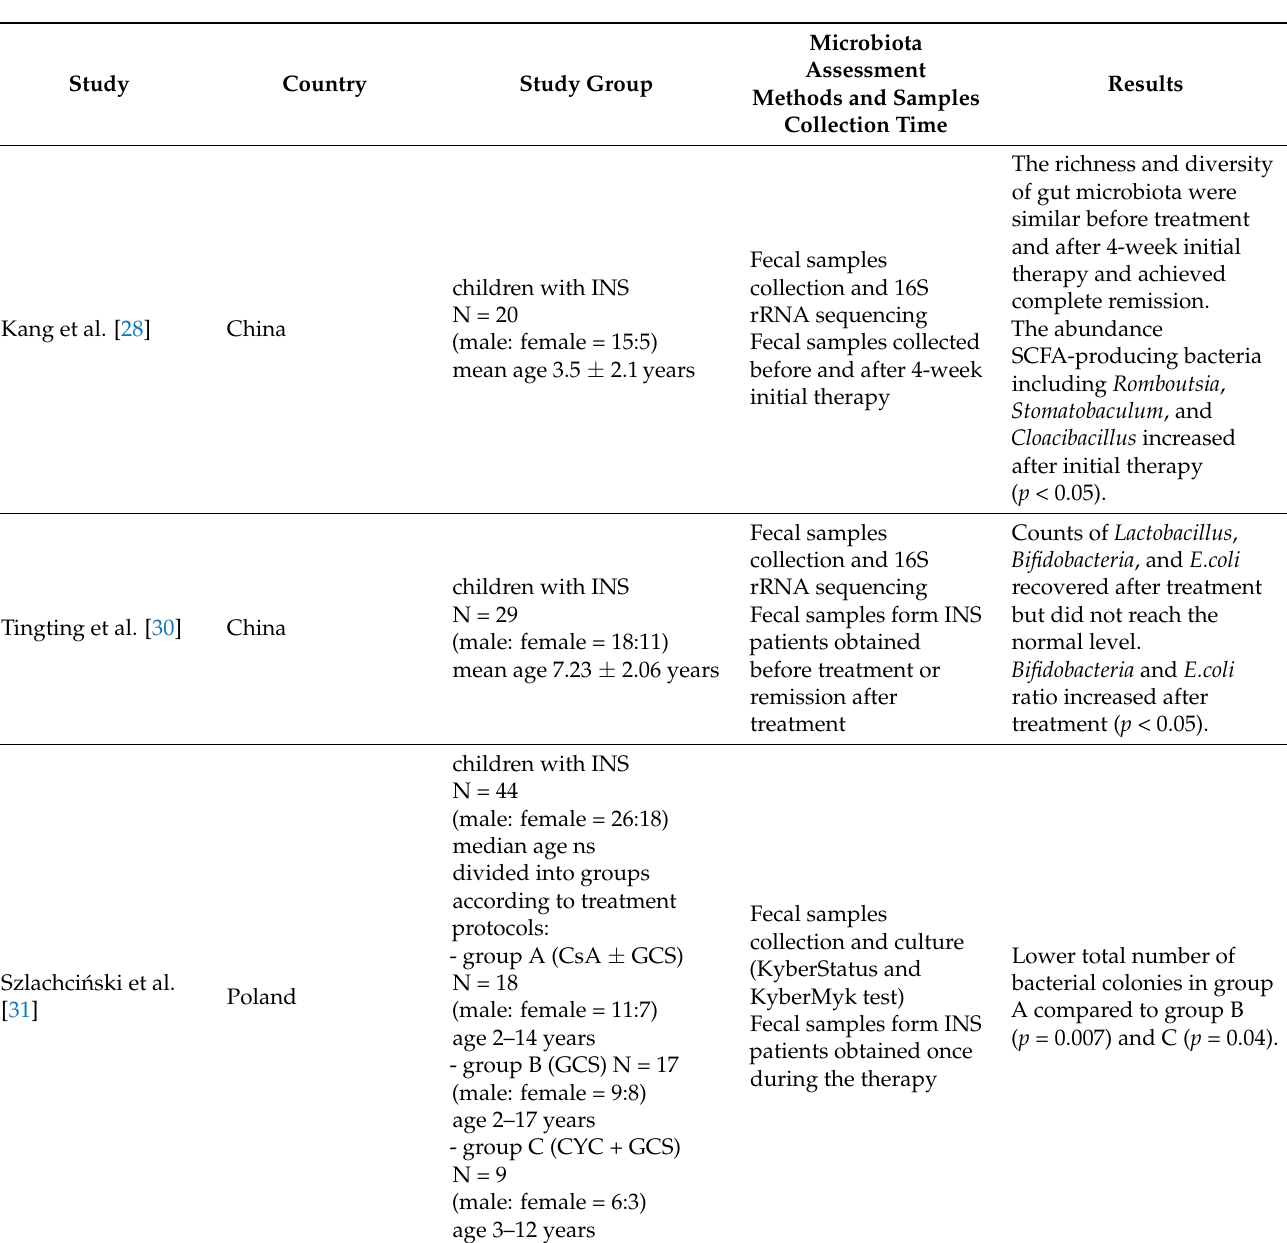
Table 2. Gut microbiota alterations in children with idiopathic nephrotic syndrome (INS) during immunosuppressive